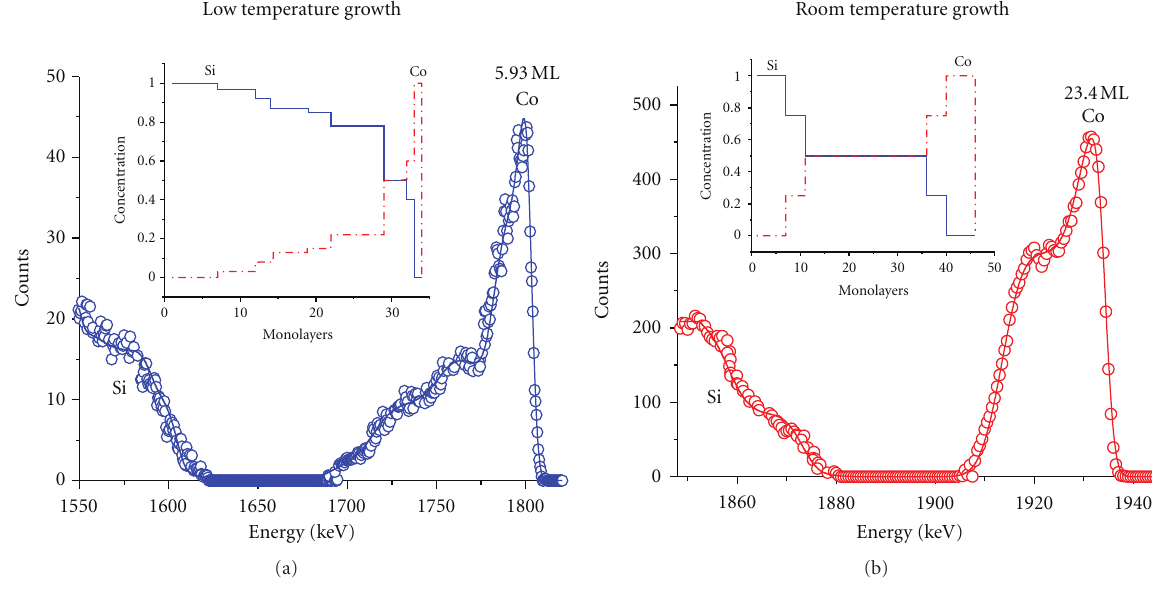
Figure 3: HRBS spectra of both the Si and Co edges: (a) 5.93 ML of Co deposited at − 60 ◦ C and (b) 23.42 ML of Co deposited at room temperature (22 ◦ C), together with simulations of the spectra by RUMP (solid lines through the data). The insets show the Si and Co concentrations at the interface as obtained from the RUMP simulations (depth scale: monolayers of Si, each 6 . 87 · 10 14 at./cm 2 thick). The right hand side of the concentration profiles corresponds to the free surface of the Co/Si. Layer 0 was deliberately put into the Si bulk.